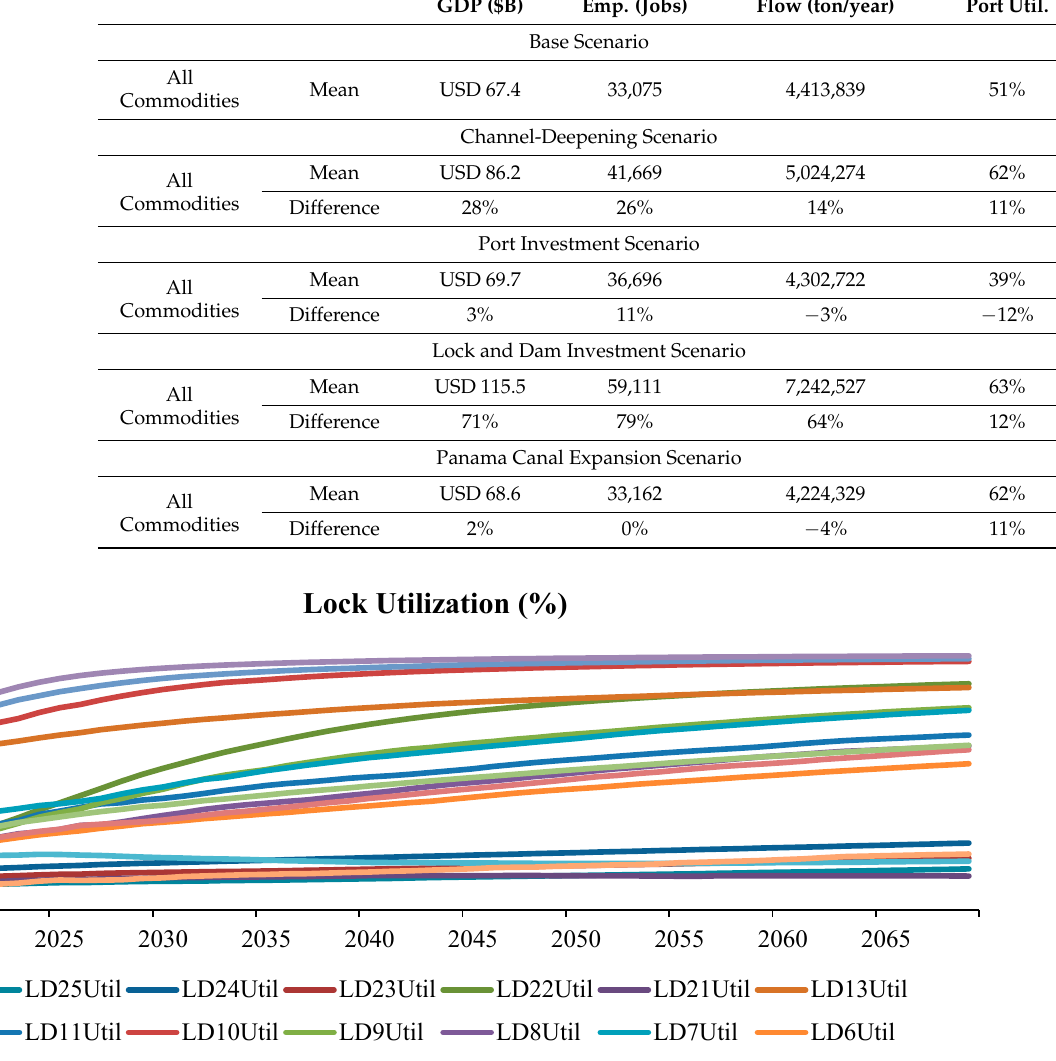
Figure 3. MKARNS port utilization by commodity type.